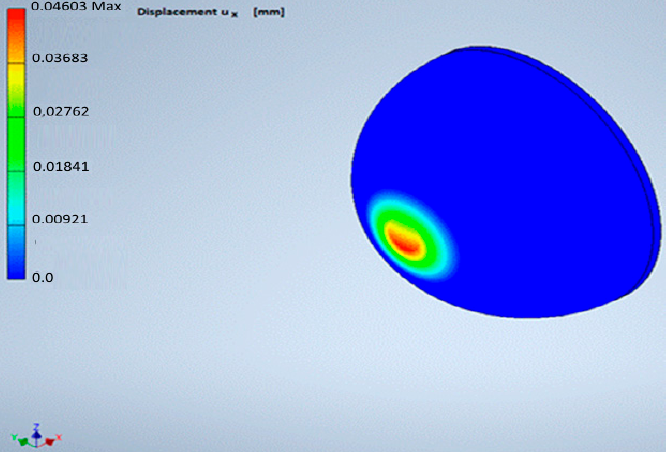
Figure 19. The displacements along the X axis for the upper surface of the tested material sample. The contact pressure between the tilt arm and the tested material sample is presented in Figure 20. Its values were below 6.5 MPa. Assuming the linear material model of ball joint bearing, for the loading force F value equal to 10 N, the contact pressure values were below 2 MPa.